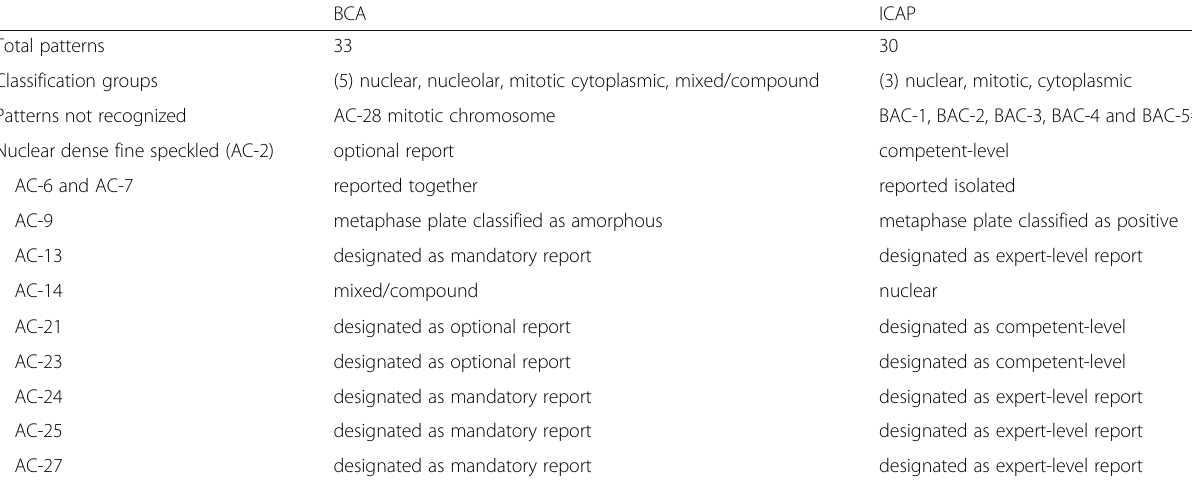
Table 1 Main differences between the Brazilian Consensus for Autoantibodies on HEp-2 cells (BCA) and the International Consensus on Ana Patterns